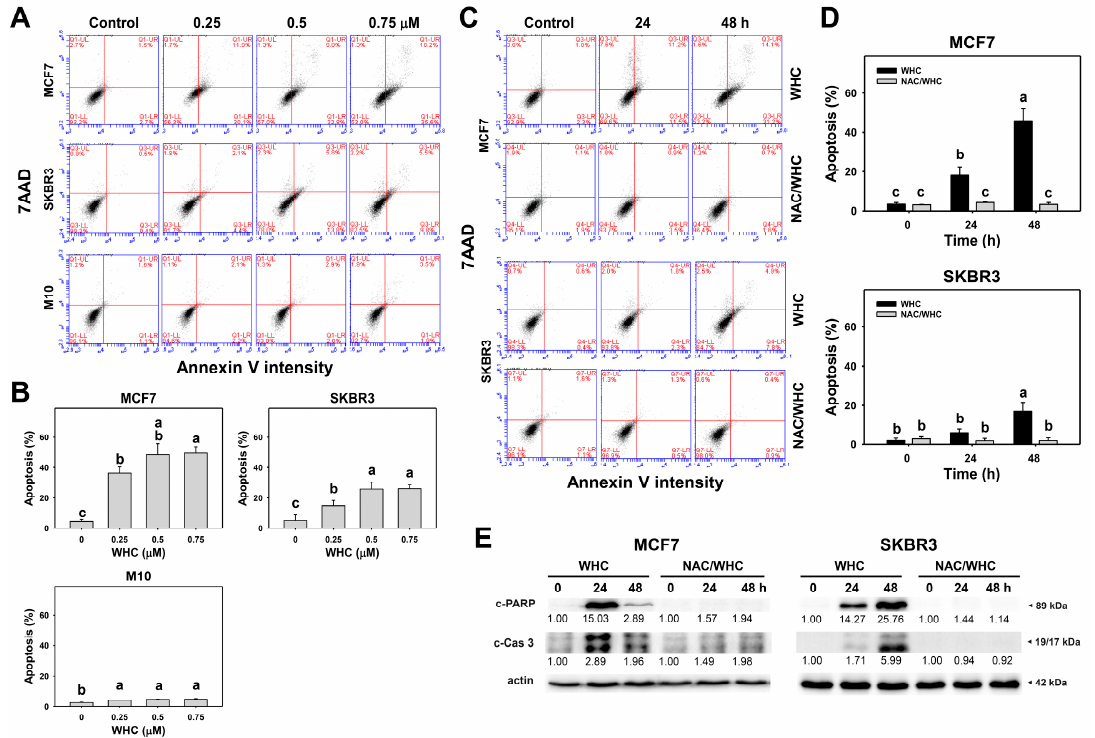
Figure 3. WHC induced apoptosis (annexin V/7AAD) differentially in breast cancer and normal breast cells. ( A , B ) Annexin V/7AAD profiles and statistics for dose effect of WHC. Breast cancer (MCF7 and SKBR3) cells and normal breast (M10) cells were treated with WHC (control (0.075% DMSO), 0.25, 0.5, and 0.75 μ M) for 48 h. Annexin V (+) (%) was counted for the apoptosis (%). ( C , D ) NAC pretreatments